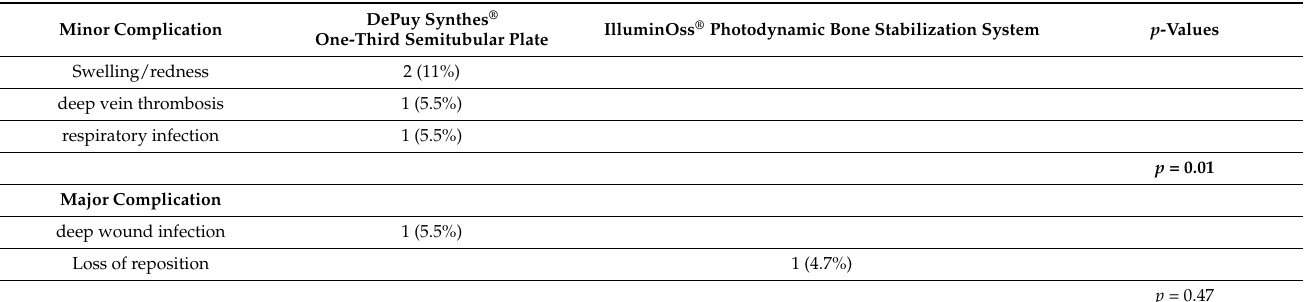
Table 3. Overview of the complications for both patient groups, Group I treated with DePuy Syn- thes one-third semitubular ® plate and Group II treated with IlluminOss ® Photodynamic Bone Stabilization